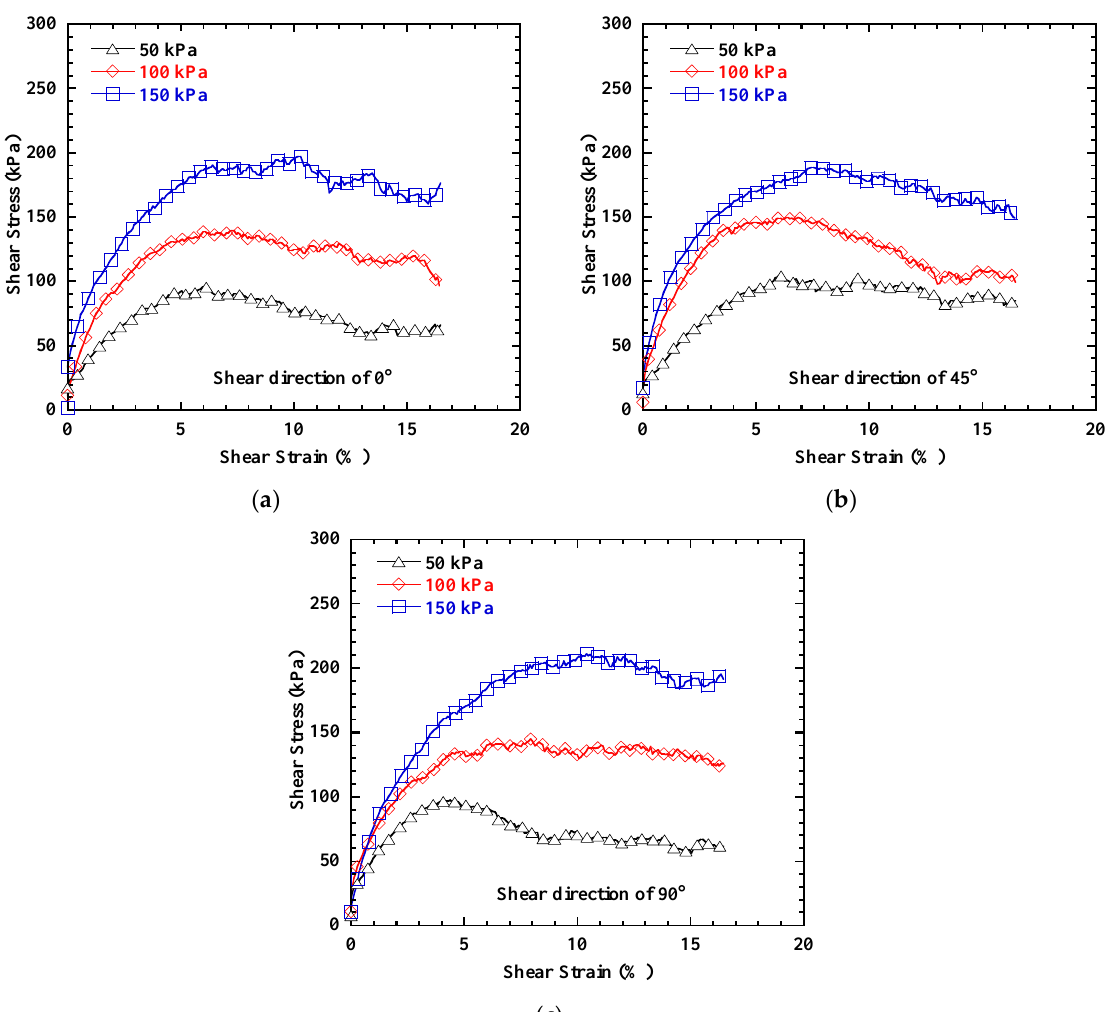
Figure 11. Shear stress–strain curves for gravel–biaxial geogrid (SS40) interfaces. ( a ) Shear direction of 0°, ( b ) shear direction of 45°, ( c ) shear direction of 90°.